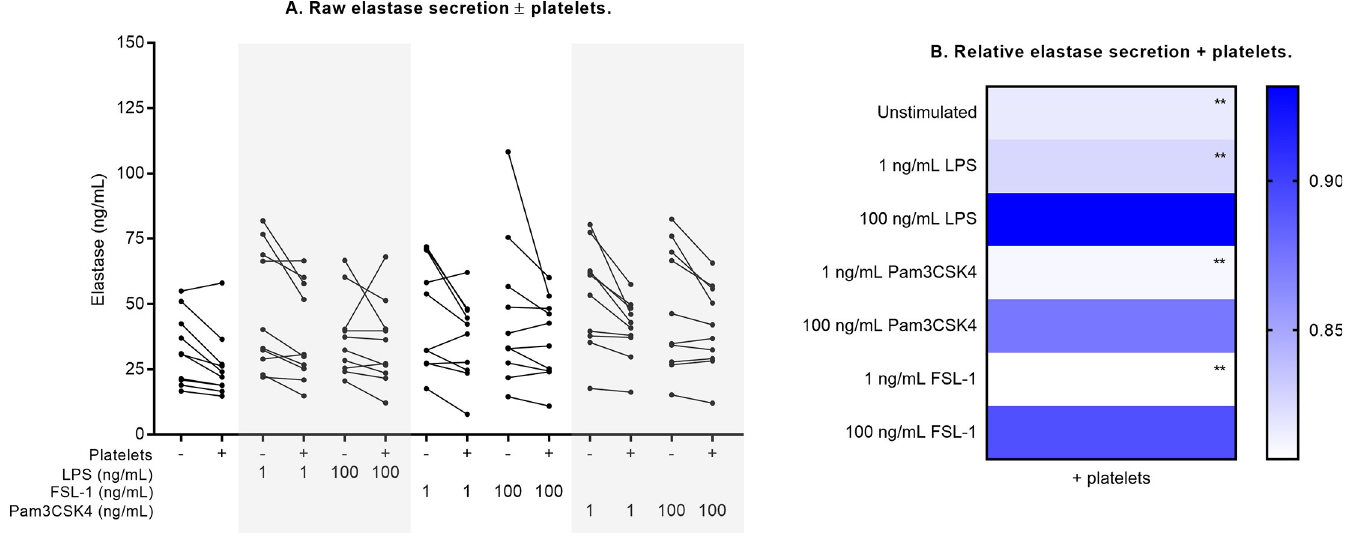
Fig 7. Neutrophil elastase secretion ± platelet co-culture. Raw elastase measurements are shown in (A) for each culture condition. Relative change in the presence of platelets is shown in (B), compared against measurements from neutrophil-only cultures normalized to 1 (ble). Differences in expression (- platelets vs. + platelets) were examined by repeated measures two-way ANOVA with post-hoc Sidak multiple comparisons tests. �� p < 0.01.